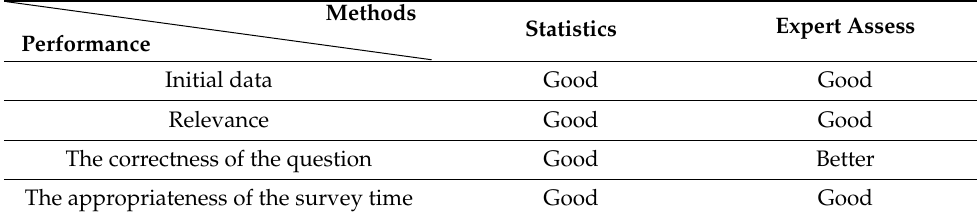
Table 3. Results of the validity test of the questionnaire.